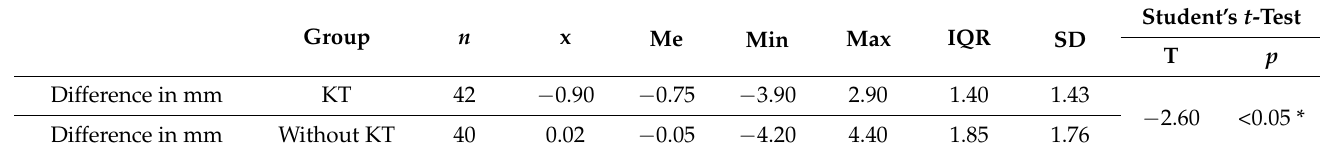
Table 3. Differences [mm] in linear measurement taken 2.5 cm above fibula neck.